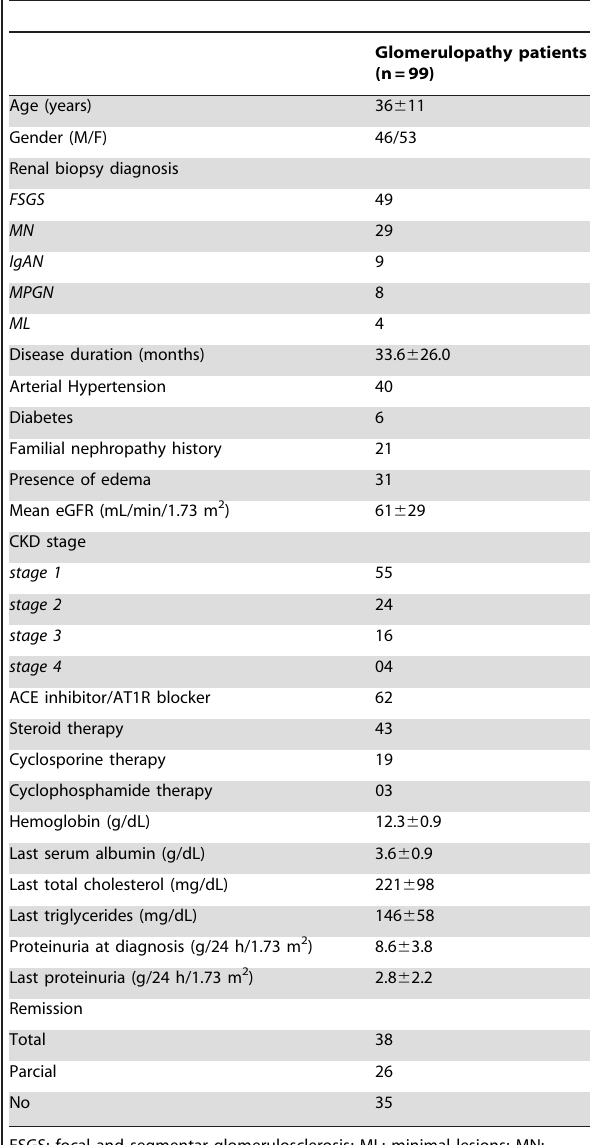
FSGS: focal and segmentar glomerulosclerosis; ML: minimal lesions; MN: membranous Nephropathy; IgAN: IgA nephropathy;